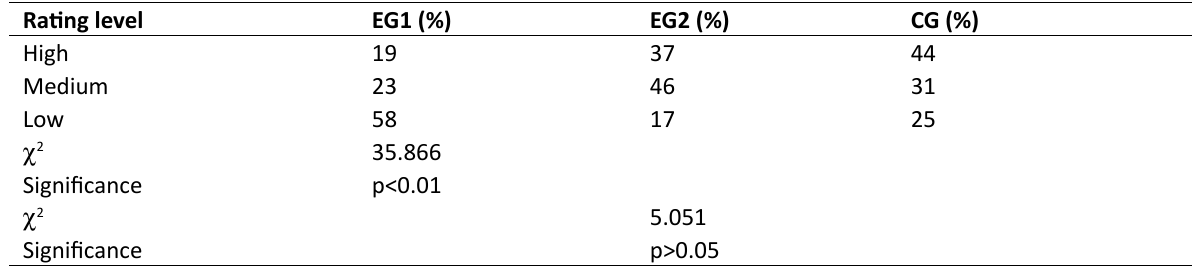
Table 2 . Comparative results of focus groups monitoring by rating system at the end of the experiment Rating level